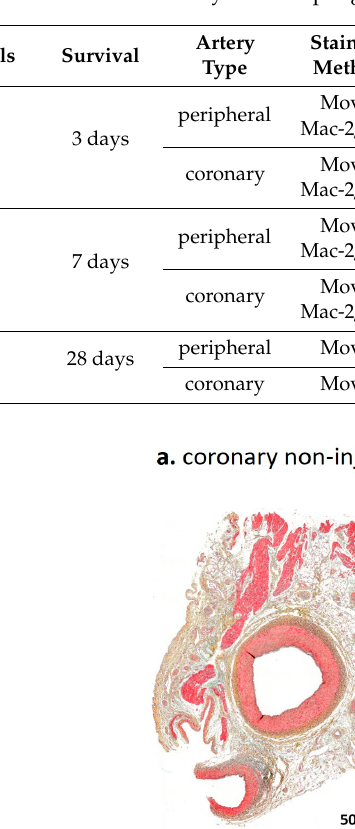
Table A1. Number of animals, arteries and sections included in the analysis. Movat-stained sections wereusedtoanalyzeinjuryscore, inflammationscore, fibrinscoreandI + M.Mac-2 / CD31double-stained sections were used to analyze macrophages, reendothelialization and neovascularization.